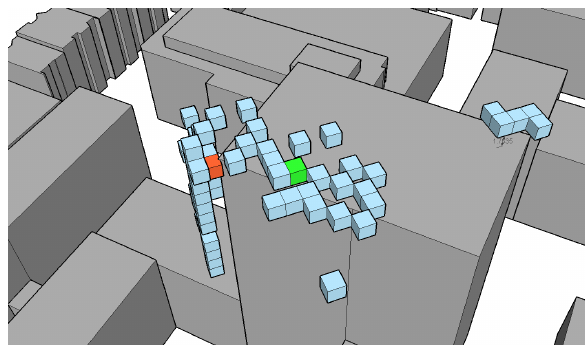
Figure 8. Visualization of the most promising cells. The green cell above the building was used to estimate the energy